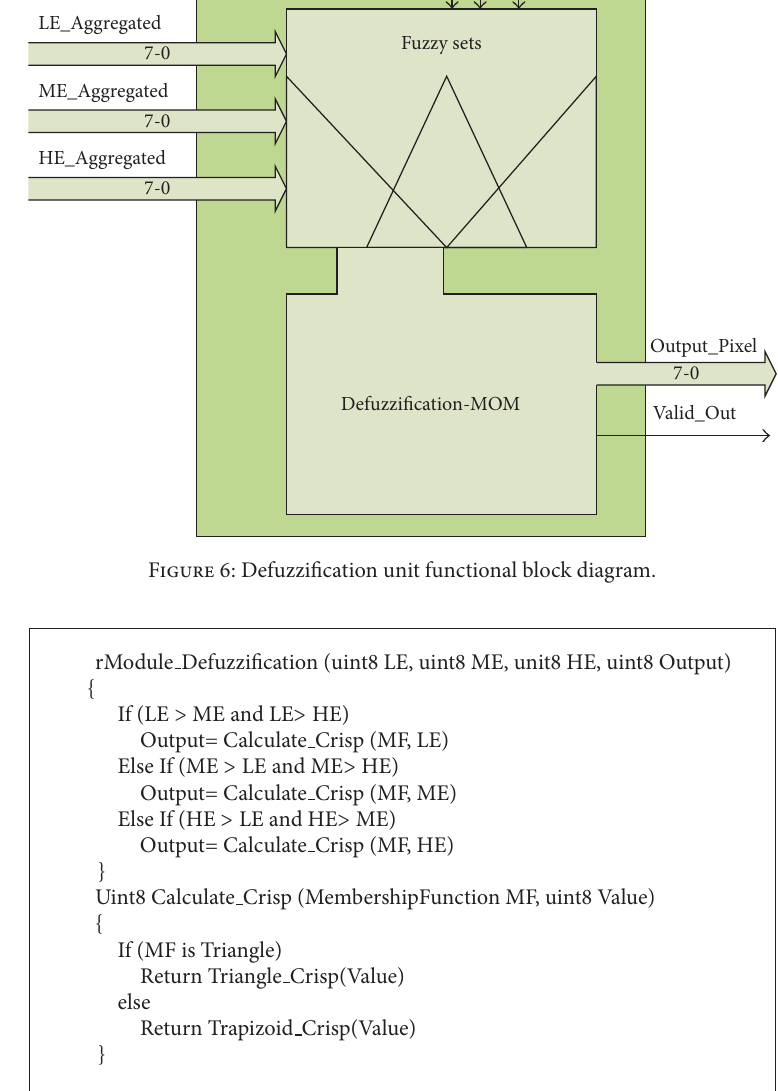
Pseudocode 1: Pseudocode for SOM